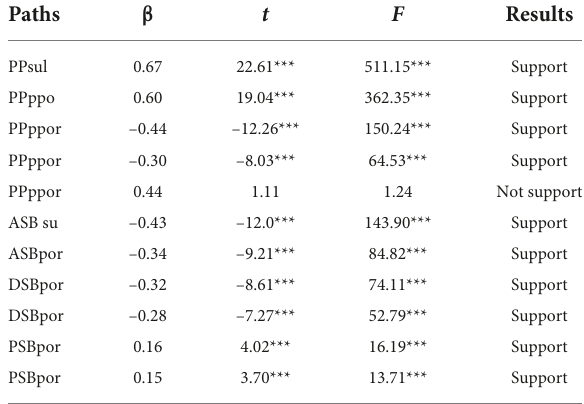
TABLE 4 Standardized direct effect of latent